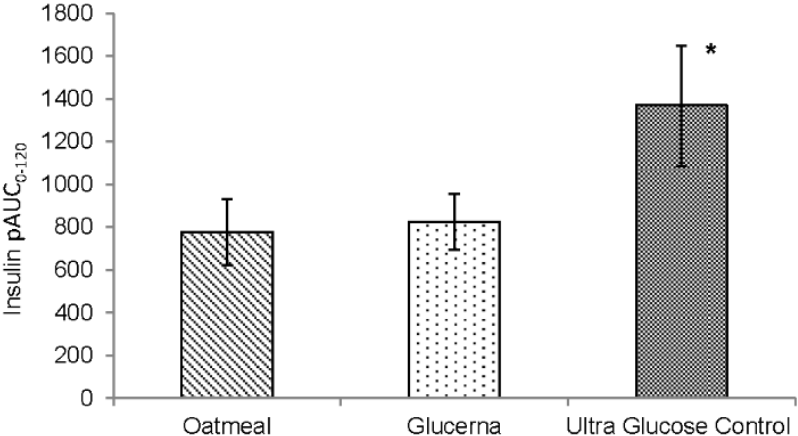
Figure 3. Postprandial insulin positive area under the curve 0–120 min (pAUC 0–120 ) in response to the breakfast meals. Values are mean ± SEM. * p < 0.05 compared to oatmeal. Mean baseline fasting values for serum active GLP ‐ 1 before OM, GL and UGC were comparable (4.18 ± 0.81, 6.91 ± 1.77 and 4.08 ± 0.78 pg/mL, respectively) (Figure 2c). Serum active GLP ‐ 1 AUC